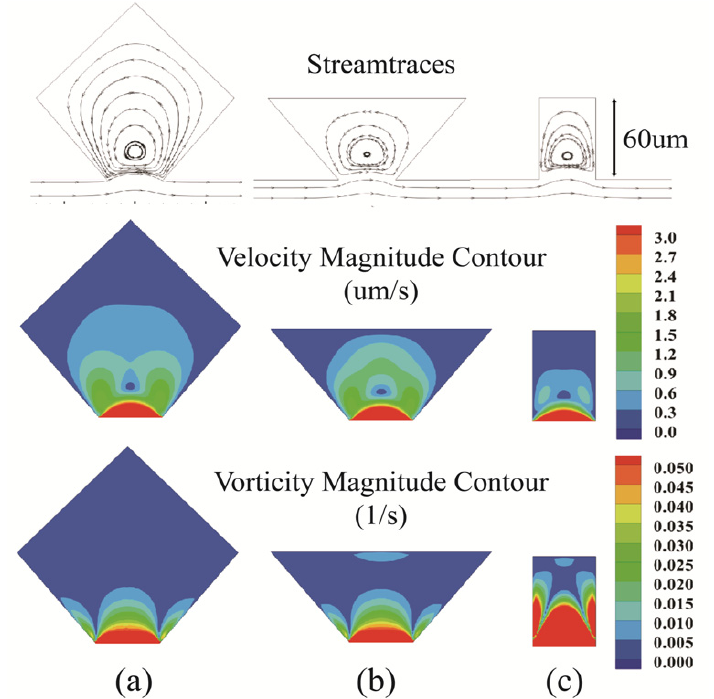
( b ), and rectangle-shaped ( c ) chamber designs. The first row shows flow streamlines, the second row shows velocity magnitude contours, and the third row shows vorticity magnitude contours. All results correspond to an inlet flow velocity of 20